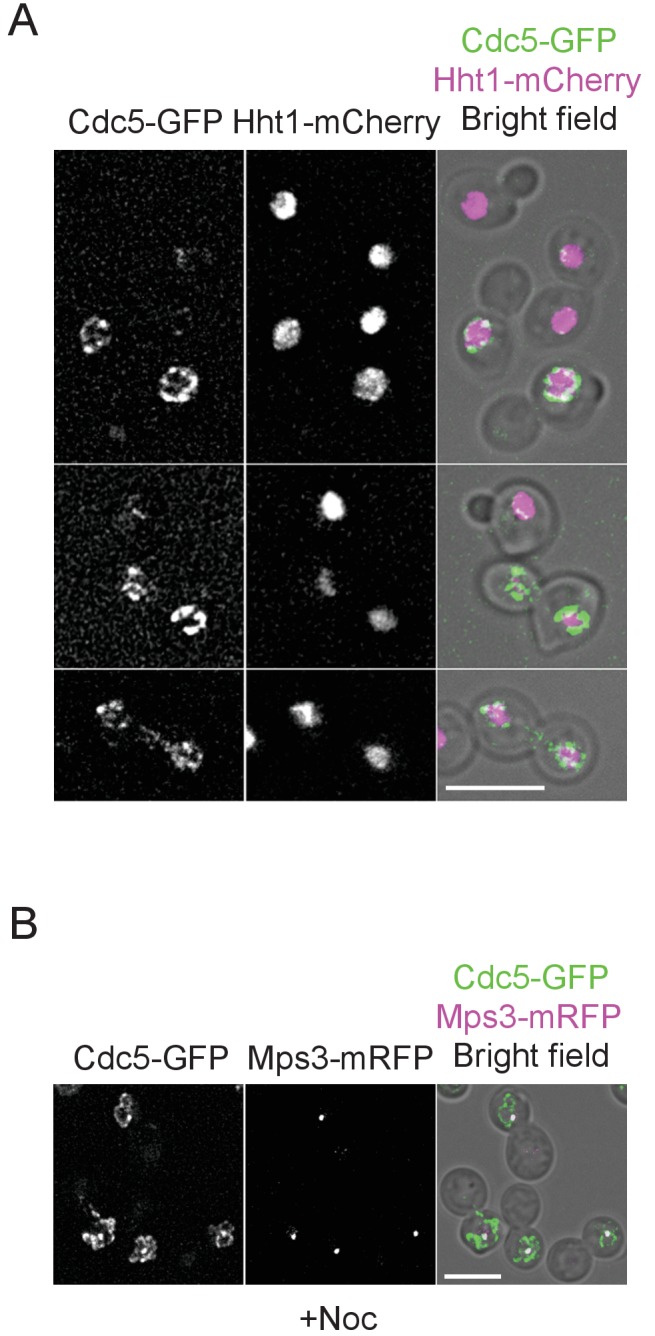
Localization of Cdc5-GFP.(A) CDC5-GFP HHT1-mCherry cells (HPH1564) were grown in YPDS at 30°C. Shown are projected images after deconvolution. Scale bar, 5 µm. (B) Cdc5 localize at SPB in nocodazole-arrested cells. CDC5-GFP MPS3-mRFP cells (HPH1562) were grown in YPDS at 30°C and incubated in the presence of nocodazole for 150 min. Shown is a projected image after deconvolution. Scale bar, 5 µm.